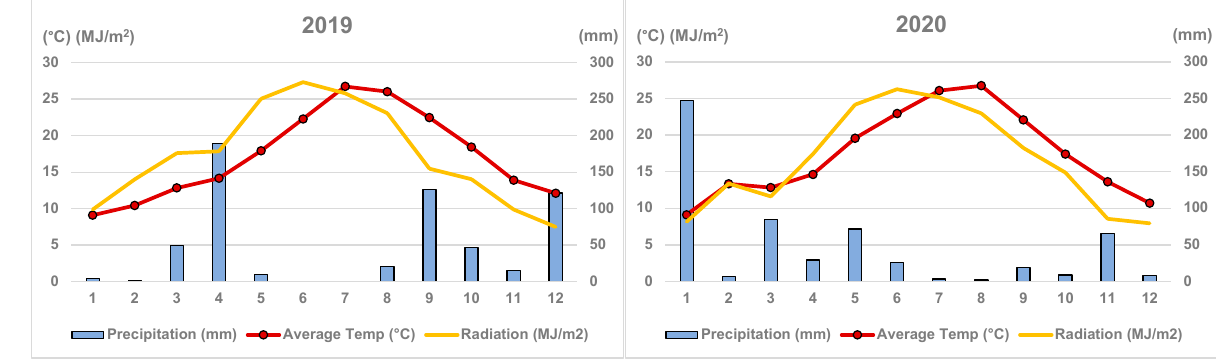
Figure 2. Trend of environmental conditions between 2017 and 2020. Monthly average temperature, in °C, and global radiation, in MJ/m 2 , are shown in the left vertical axis, and precipitation, in mm, is referred to in the right vertical axis.